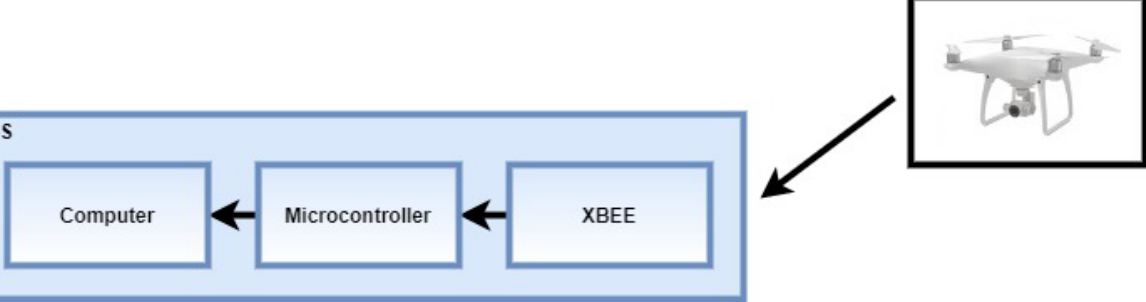
Figure 1. Scheme of reception and storage of the wireless signal measurement